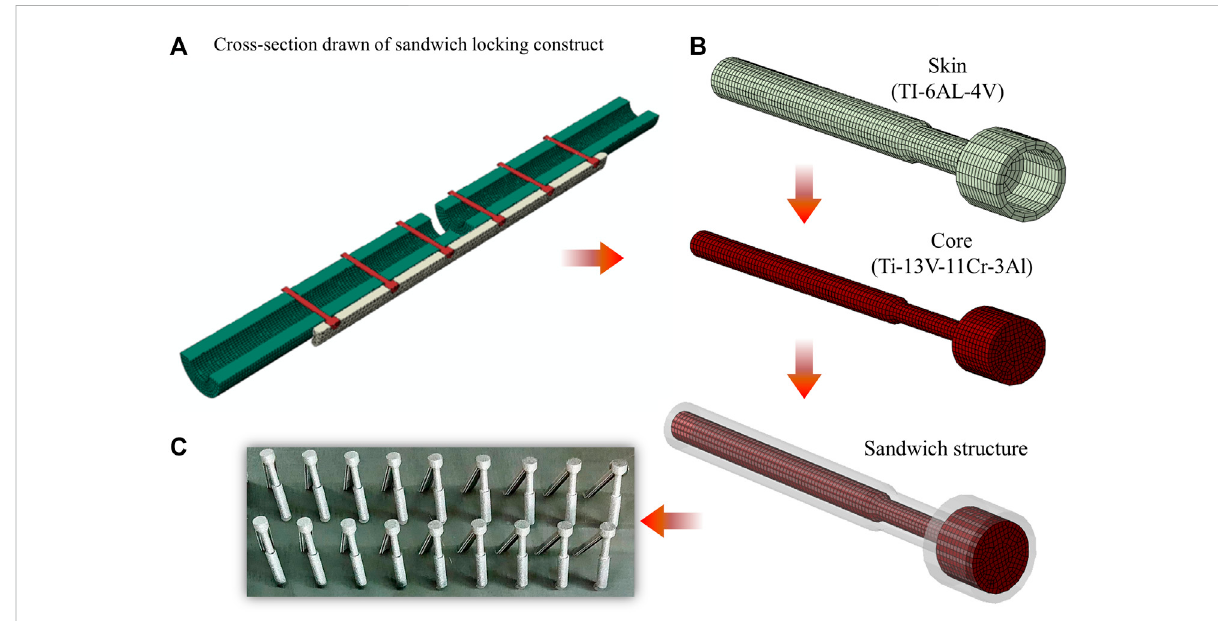
FIGURE 3 Structure schematic diagram of the optimized fi nite element model of the SWL screw. (A) Cross-section drawn of sandwich locking construct. (B) Thebestresultofoptimizationisd=0.25mm,t=0.65 mmandE=98 GPa.Consideringthein fl uenceofmaterialcompatibility,titaniumalloy(Ti- 13V-11Cr-3Al) was selected as the core material (Young ’ s modulus E = 98 GPa and Poisson ’ s ratio γ = 0.3). (C) Implant manufactured by 3D printing using titanium alloy (TI-6AL-4V) as a proof-of-concept.